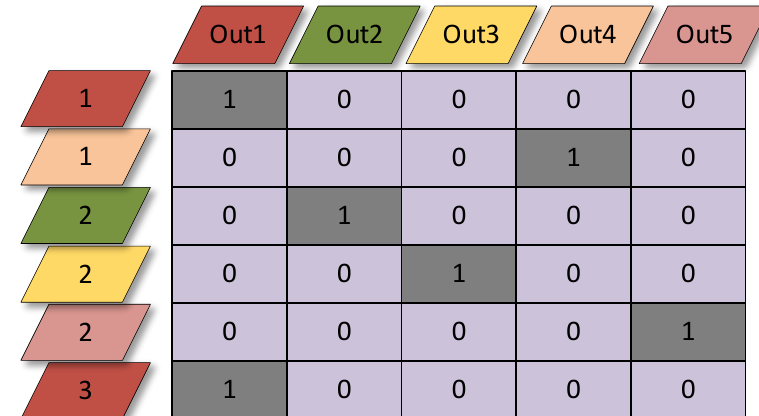
Figure 2. Initial value assignment of the example shown in Figure 1. The left set of parallelograms represents the middle features. The numbers in these parallelograms mean the index in the input features. The upper set of parallelograms represents the output features. The same color between the left parallelogram and the top one means that they are matched in picking stages. The value in the matrix means the initial value of the additional